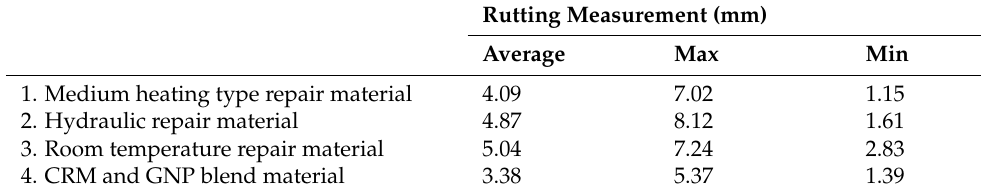
Table 8. The measurement result of transverse strain after 1